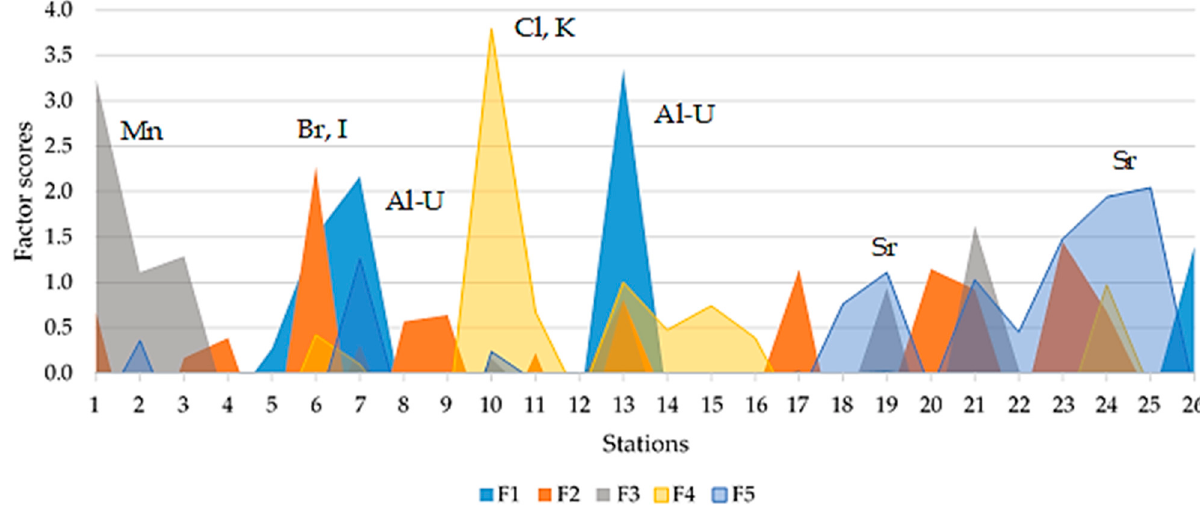
Figure 3. The distribution of the factor scores of five factors among all of the studied sites.